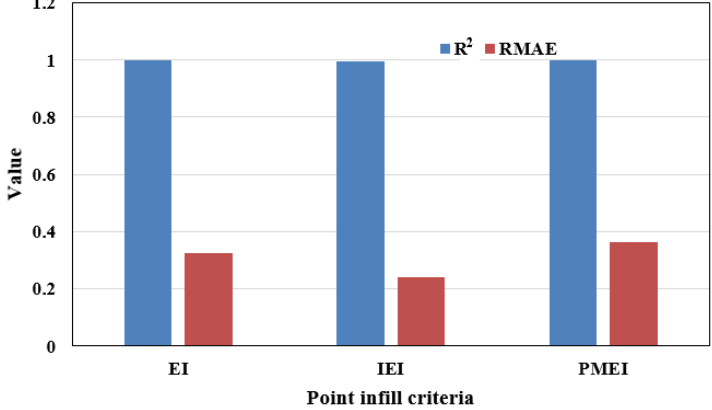
Figure 6. The absolute error for the two-dimensional function.